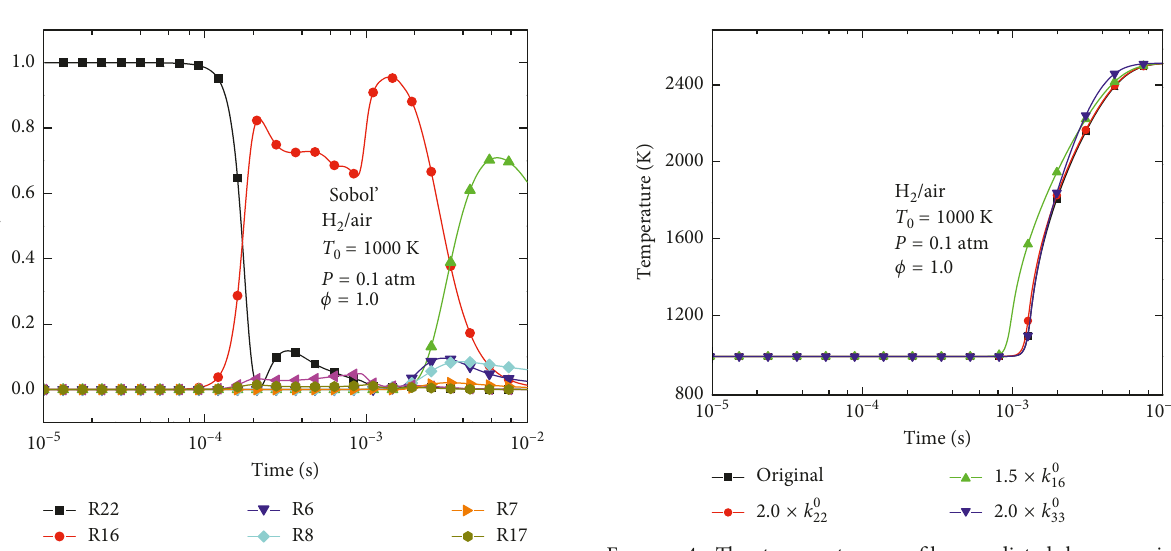
Figure 4: The temperature profiles predicted by an original combustion model and 3 modified models. 2 . 0 × k 0 i indicates that the rate of the reaction (i) of this modified model is calculated with the original reaction rate k 0 i multiplied by 2.0, and other reaction rates of the modified model are the same as those of the original